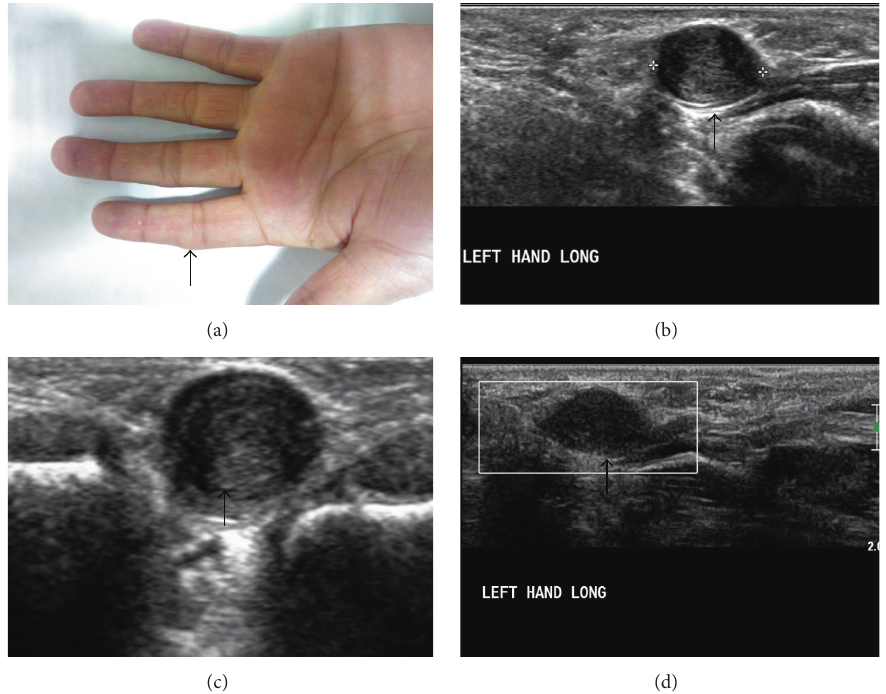
Figure 6: Schwannoma. A 25-year-old female patient presented with firm, noncompressible swelling over the radial aspect of the proximal interphalangeal joint of 2nd digit ((a), arrow). Ultrasonography ((b)–(d)) showed a well-defined, oval, hypoechoic, hypovascular lesion